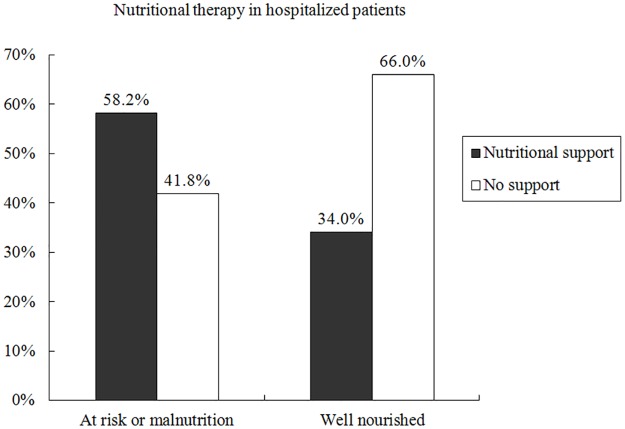
Nutritional therapy in Chinese hospitals.